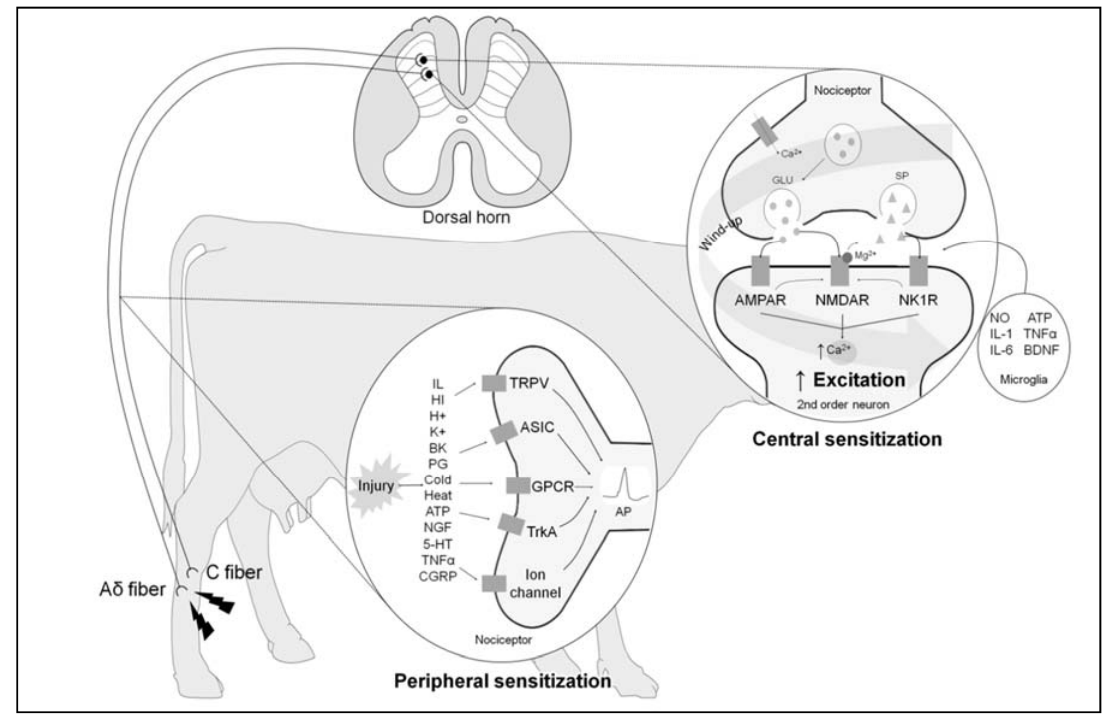
Figure 2. Peripheral and central sensitisation processes. After tissue injury, multiple chemical mediators (e.g., interleukin (IL), histamine (HI), H + , K + , bradykinin (BK), prostaglandin (PG), cold, heat, adenosine triphosphate (ATP), nerve growth factor (NGF), serotonin (5 ‐ HT), tumour necrosis factor (TNF α ) and calcitonin gen related peptide (CGRP)), known as “sensitizing soup”, activate receptors in nociceptors (transient receptor potential cation channel (TRPV), acid ‐ sensing ion channels (ASIC), G ‐ protein ‐ coupled receptors (GPCR), tropomyosin receptor kinase A (TrkA) and ion channel), increasing the ratio of action potentials that results in continuous depolarisation and increased sensitisation of peripheral pain receptors. When harmful stimuli reach second ‐ order neurons in the dorsal horn of the spinal cord, excitatory substances like glutamate (GLU) and substance P (SP) are released by the nociceptors into secondary neurons. Activation of α‐ amino ‐ 3 ‐ hydroxy ‐ 5 ‐ methyl ‐ 4 ‐ isoxazolepropionic acid receptor (AMPAR), N ‐ Methyl ‐ D ‐ aspartate receptor (NMDAR), neurokinin ‐ 1 receptor (NK1R) and simultaneous changes increase intracellular Ca 2+ concentrations, enhancing transmission and excitation, together with the so ‐ called wind ‐ up phenomenon after repeated activation of nociceptive fibres. Other mediators produced by glial cells (e.g., nitric oxide (NO), IL ‐ 1, IL ‐ 6, ATP, TNF α and brain ‐ derived neurotrophic factor (BDNF)) contribute to the central sensitisation and amplification of responsiveness to painful sensations and the development of hyperalgesia to sensory inputs.